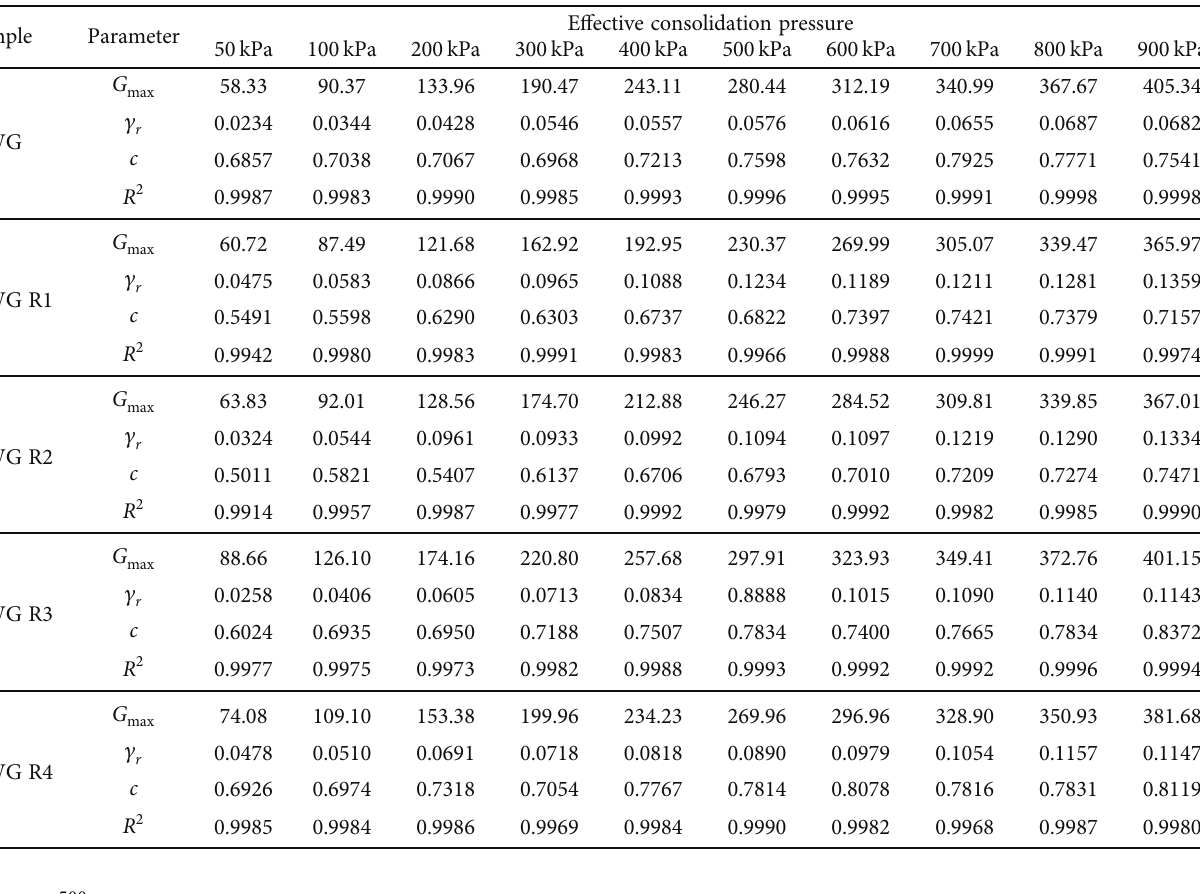
Table 3: Fitting parameters of experimental data at various dry densities.